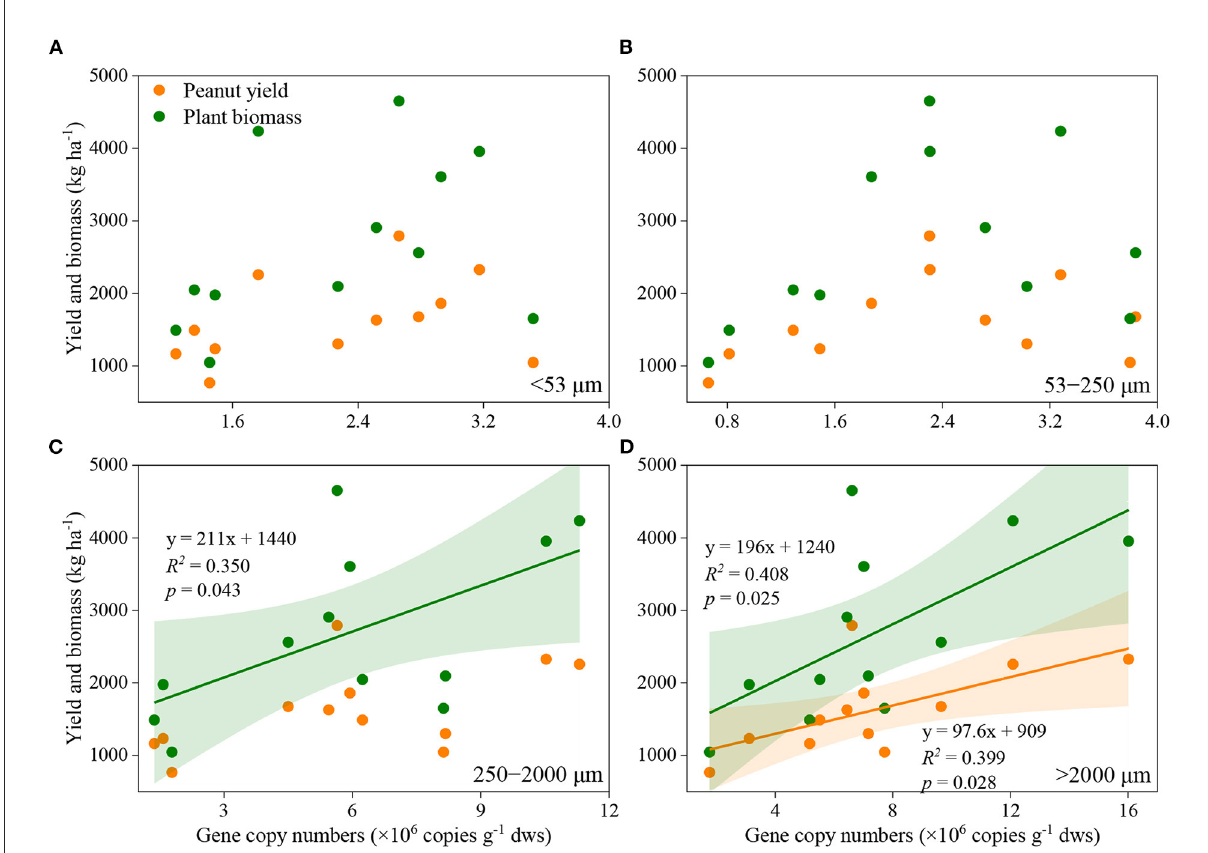
FIGURE3 Association between peanut yield or plant biomass and the abundance of nifH gene in silt and clay (A) , microaggregates (B) , small macroaggregates (C) , and large mcroaggregates (D) . The shaded area indicates the 95% confidence interval of the regression models.